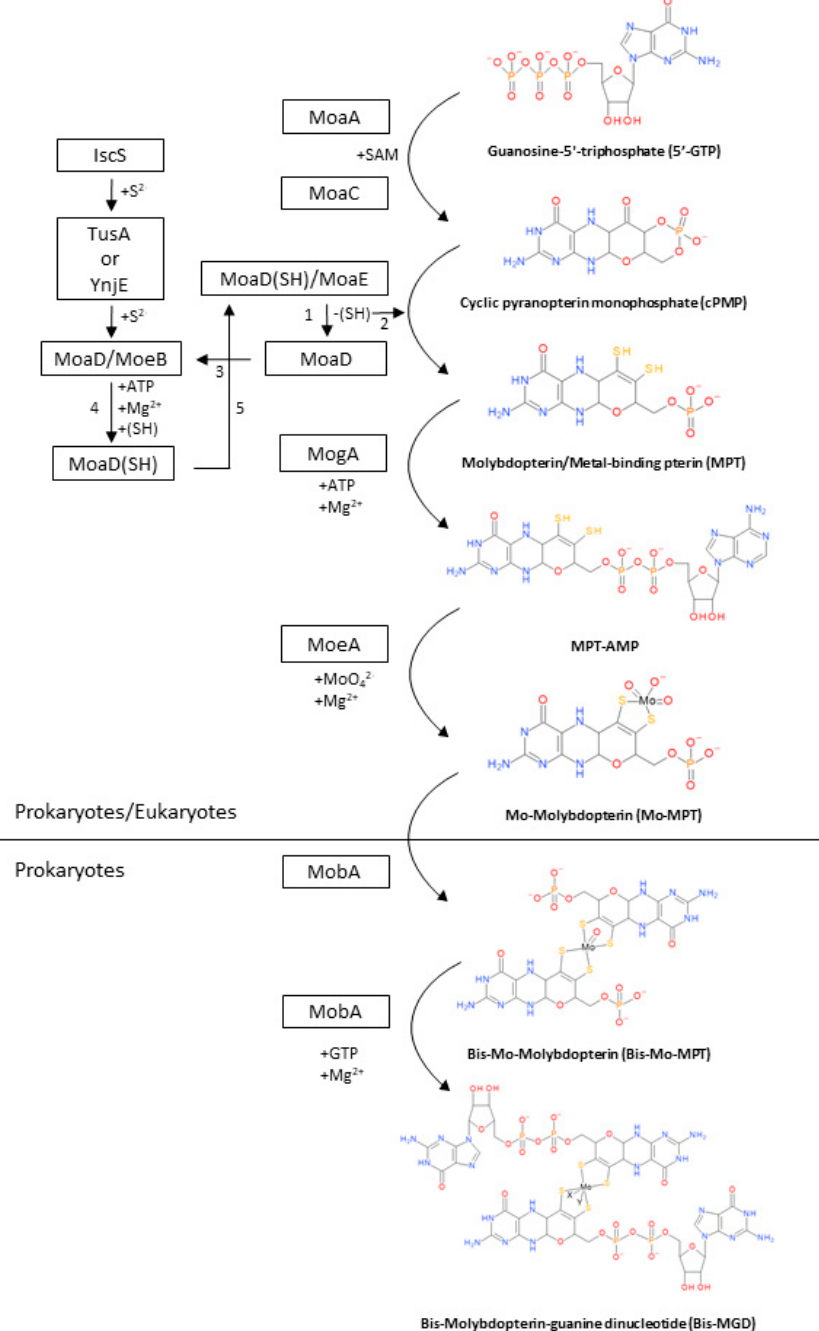
Figure 2. Biosynthesis of the bis-molybdopterin-guanine dinucleotide (Bis-MGD) cofactor. 1 and 2: Transference of the sulfur atom to the cPMP by active MPT synthase and dissociation of MoaD/MoaE. 3: Association of MoaD with MoeB. 4: Restoration of thiocarboxylate group and dissociation of MoaD/MoeB. 5: Reassociation of MoaD/MoaE (with the thiocarboxylate group). Molecules drawn with BioVIA Draw 2019.